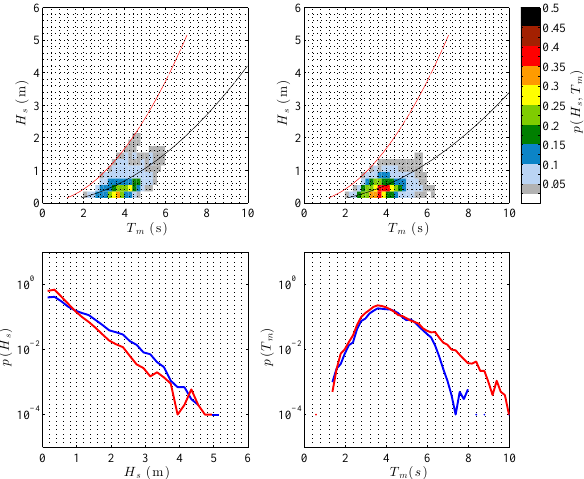
Figure 3. Observed bivariate wave climate at Acqua Alta: his- tograms representing the joint PDFs of H s and T m for Bora (top- left panel) and Sirocco (top-right panel) sea states and the corre- sponding marginal PDFs of H s (bottom-left panel; blue for Bora, red for Sirocco) and T m (bottom-right panels; blue for Bora, red for Sirocco). Black solid lines in the top panels denote average wave steepness 2 πH s /g/T 2 m (3% for Bora, 2% for Sirocco, g being grav- itational acceleration), red solid lines denote wave breaking limit (7%). Resolutions are (cid:49)H s = 0 . 2m and (cid:49)T m = 0 .